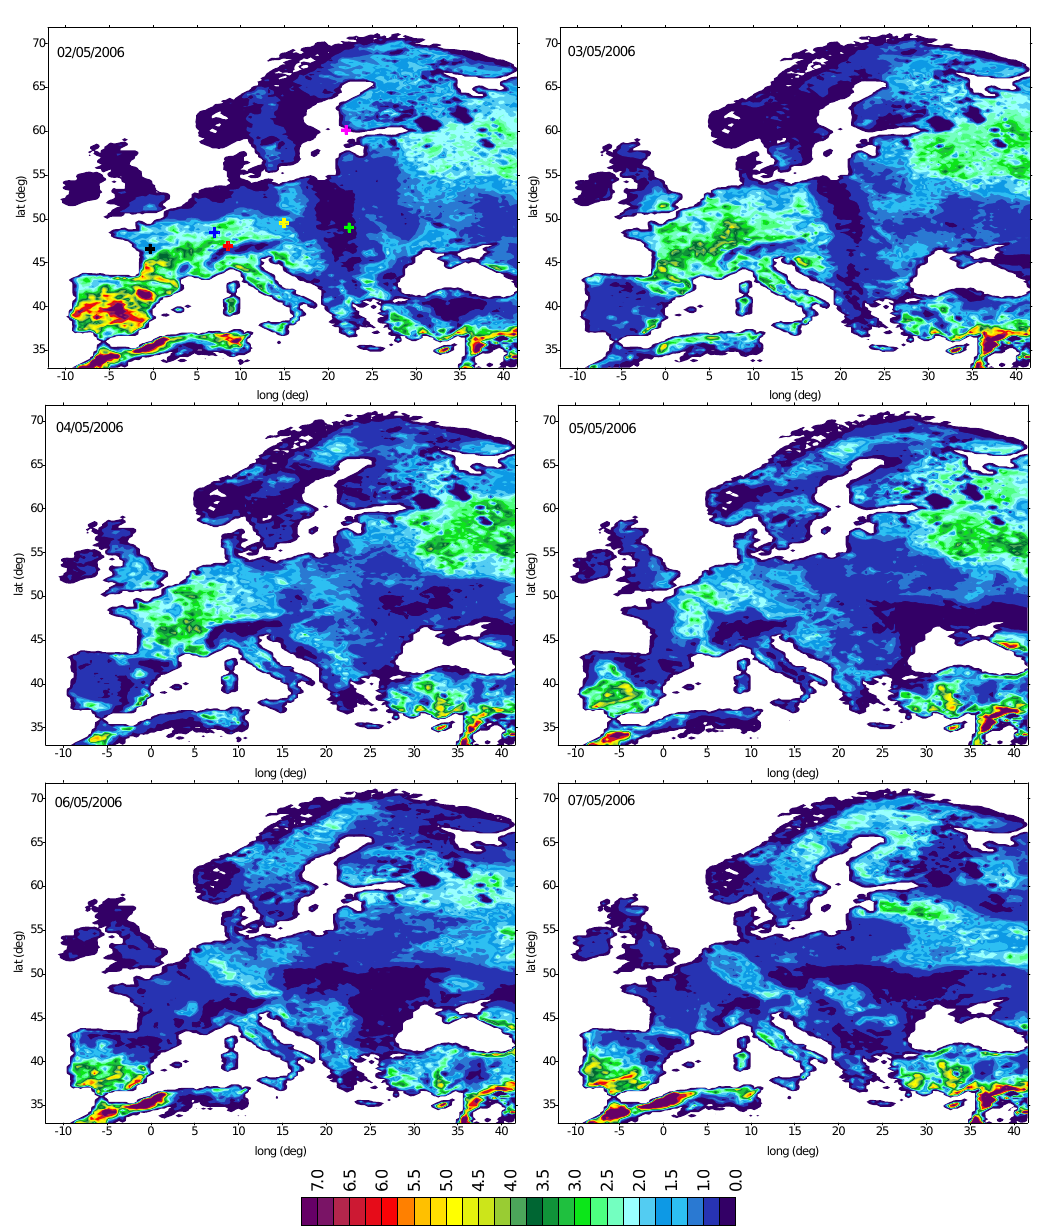
Fig. 1. Daily BVOC emission rates (mgm − 2 day − 1 ) estimated with MEGAN for 2 to 7 May 2006. The symbols in the first plot correspond to monitoring stations measuring isoprene (red: CH0005R; black: FR0015R; blue: FR0008R; yellow: CZ0003R; magenta: FI0009R; green: